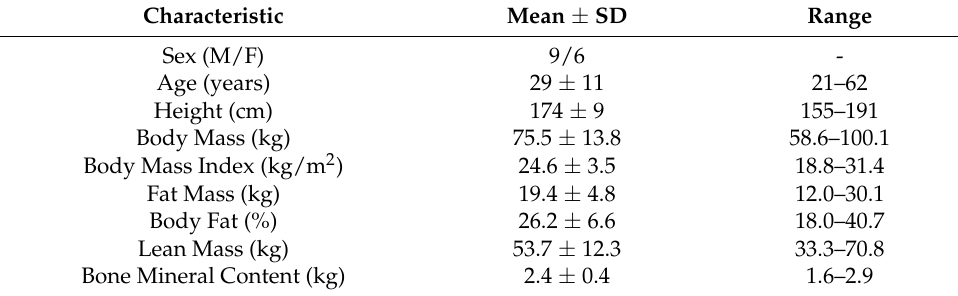
Table 1. Selected physiological characteristics of study